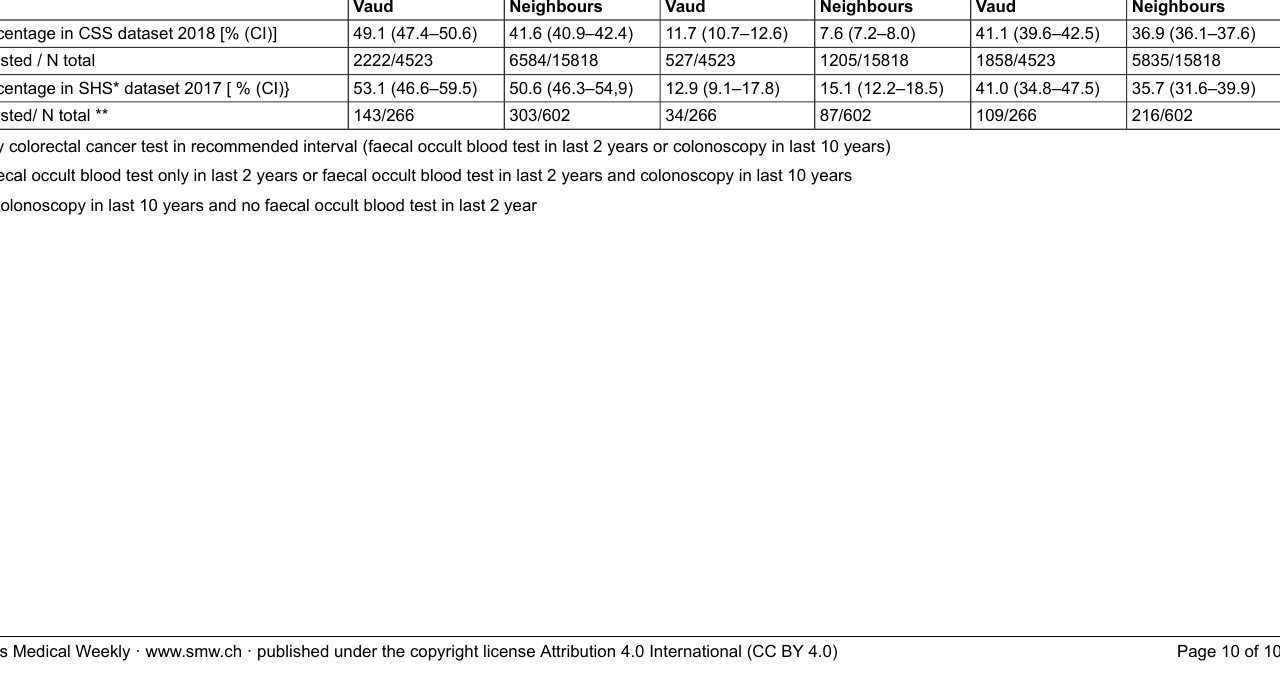
Table S3: Proportion of population up to date with testing (colonoscopy within last 9 years or faecal occult blood test within last 2 years) in SHS + population in 2017 and CSS population in 2018 respectively, aged 59 to 69 for Vaud and neighbouring cantons; SHS database 2017 and CSS database 2018 * Testing overall* Faecal occult blood test**